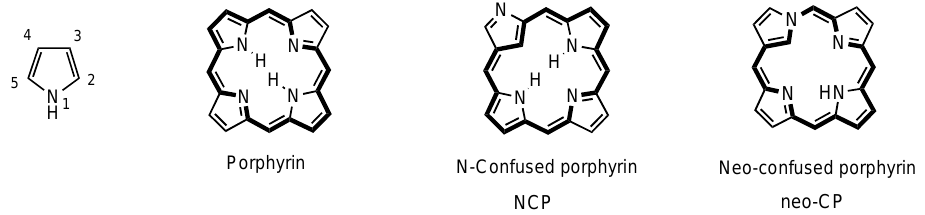
Figure 9. Structures of porphyrin and two of its constitutional isomers.